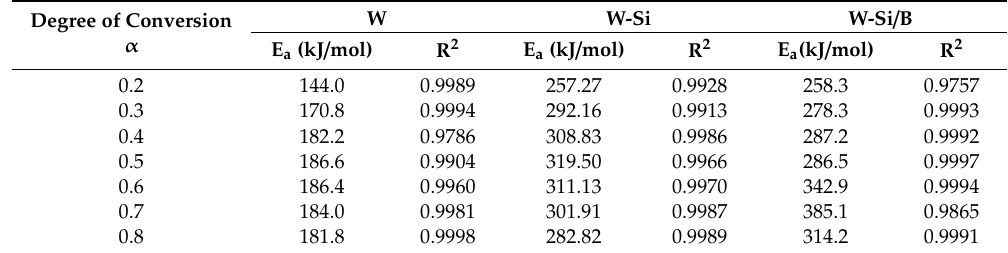
Table 2. Kinetic parameters of